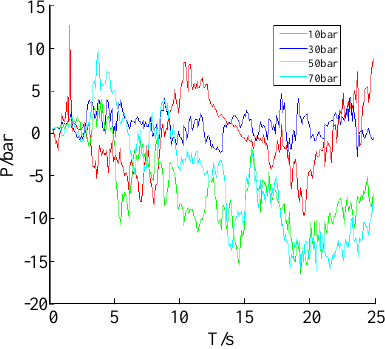
Figure 12. The pressure fluctuations of the cylinder under different charging pressures of the accumulator.